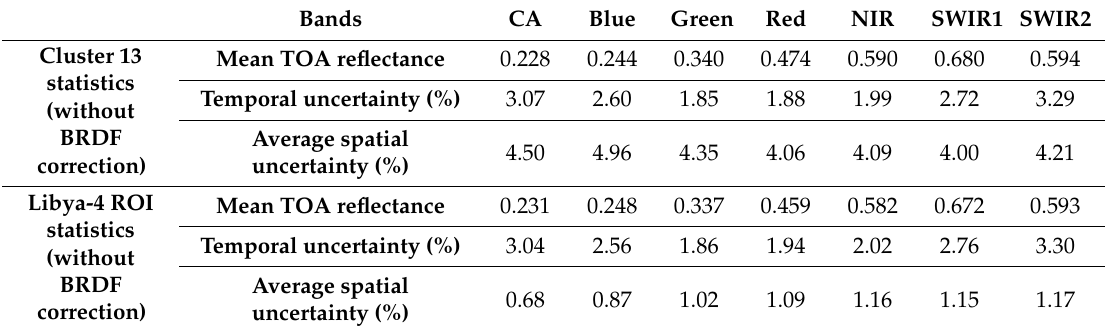
Table 3. Custer 13 vs. Libya-4 temporal and spatial characteristics without BRDF correction. Bands CA Blue Green Red NIR SWIR1